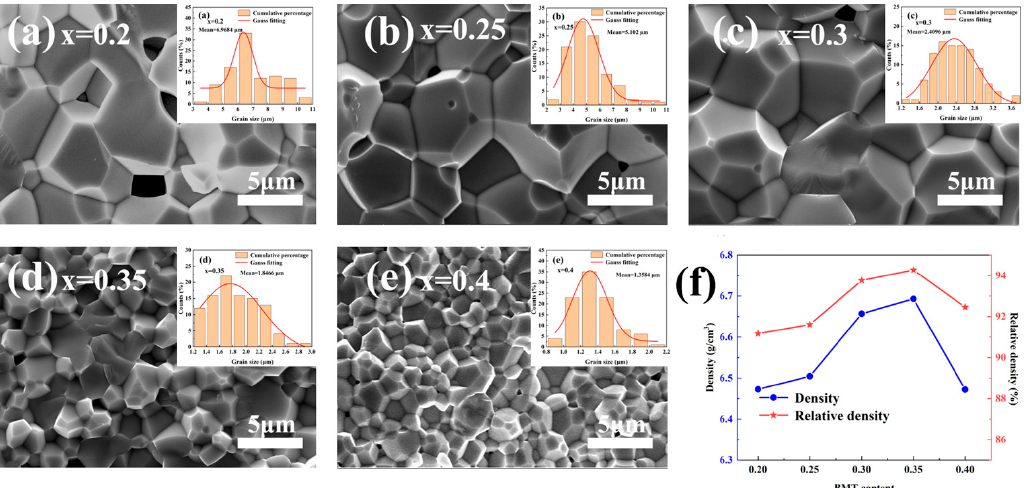
Figure 2. SEM images of (0.4-x)BF-xBMT-0.6BT bulk ceramics: ( a ) x = 0.2; ( b ) x = 0.25; ( c ) x = 0.3; ( d ) x = 0.35; ( e ) x = 0.4; ( f ) density and relative density.